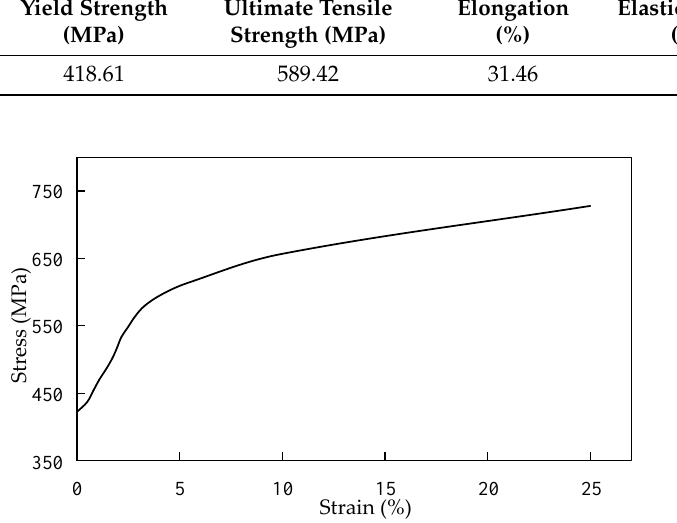
Table 2. Mechanical properties of Q345B seamless steel tube.